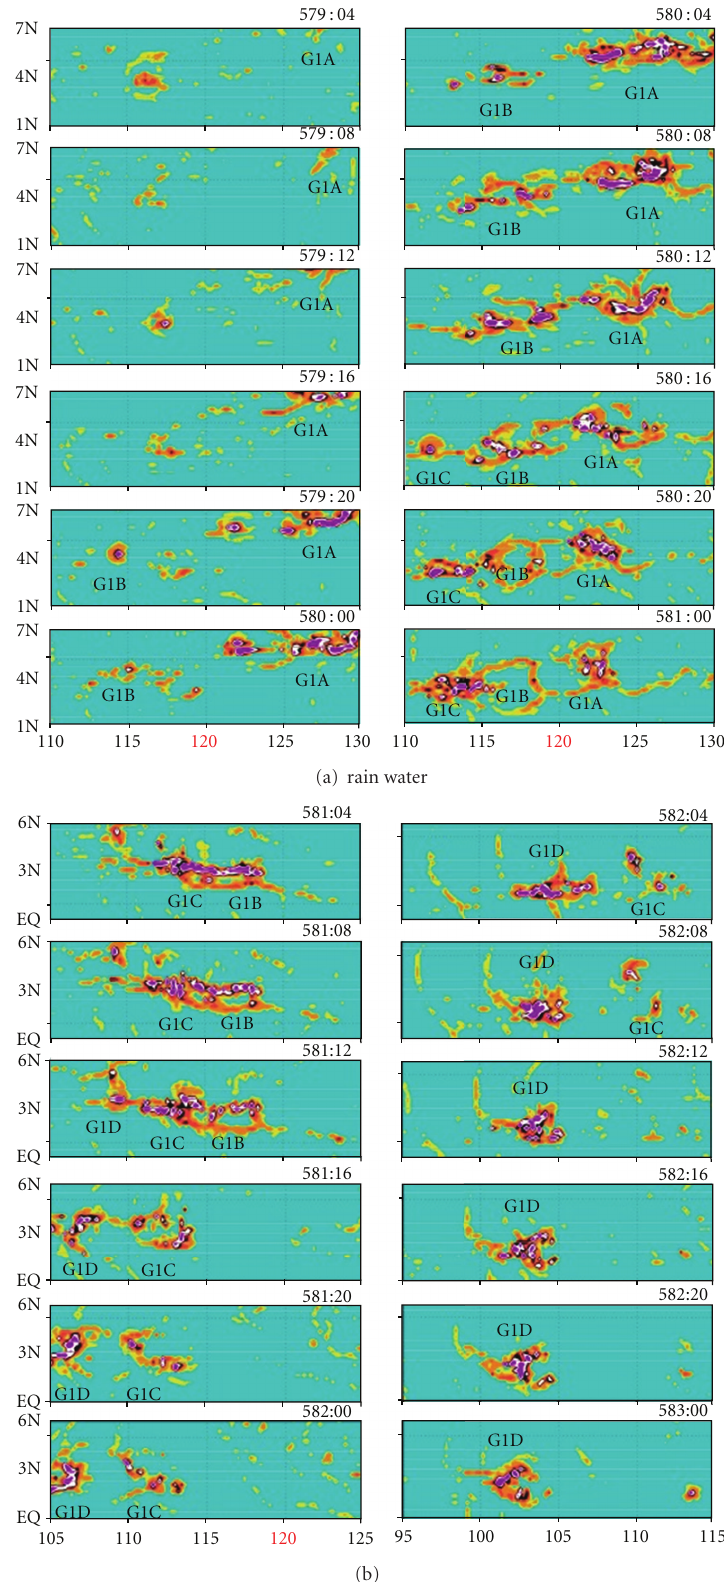
Figure 11: Horizontal distribution of the low-level rainwater mixing ratio in case (R) at a time interval of 4 hours; (a) from 579 day 04 hour to 581 day 00 hour, and (b) 581 day 04 hour–583 day 00 hour. Each of mesoscale convective systems, which constitute cloud cluster G1, is labeled by G1A, G1B, G1C, and